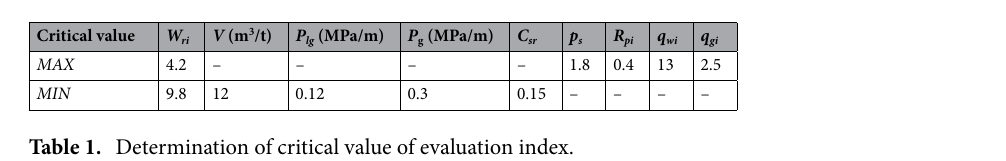
Table 1. Determination of critical value of evaluation